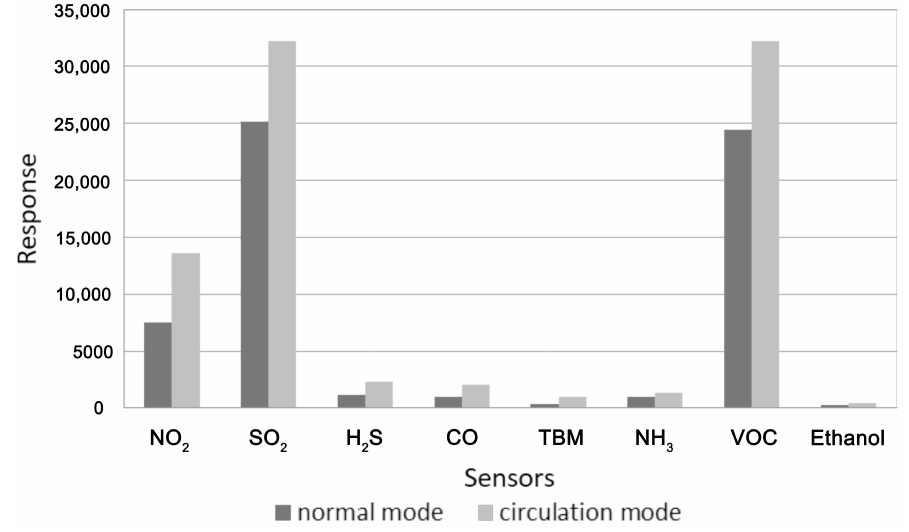
Figure 8. Sensor response signals for poultry meat samples after five days of storage with and without circulation